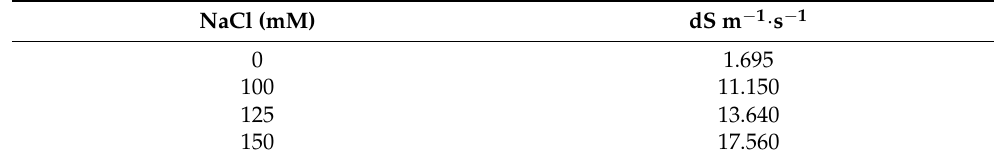
Table 5. Conductivity of commercial soil watered with NaCl solution of 0, 100, 125, 150